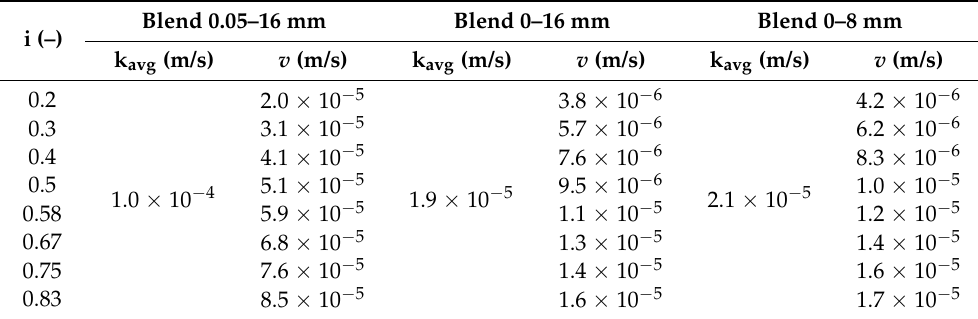
Table 3. Calculation of the flux velocity on the basis of the mean coefficient of permeability